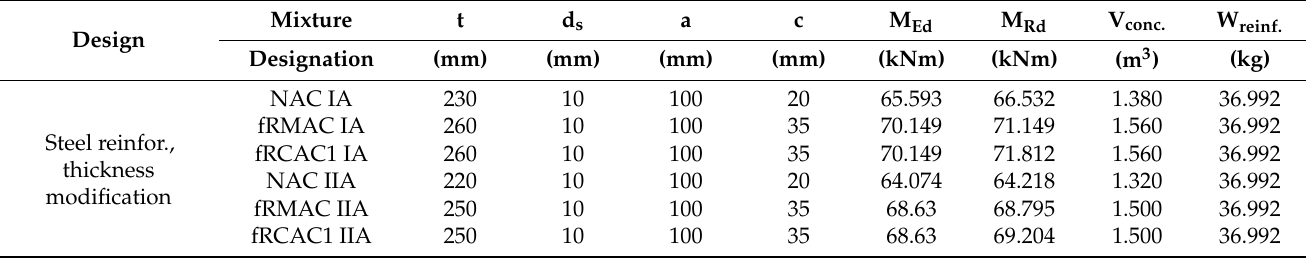
Table 5. Limit state of load-bearing capacity, results of design and